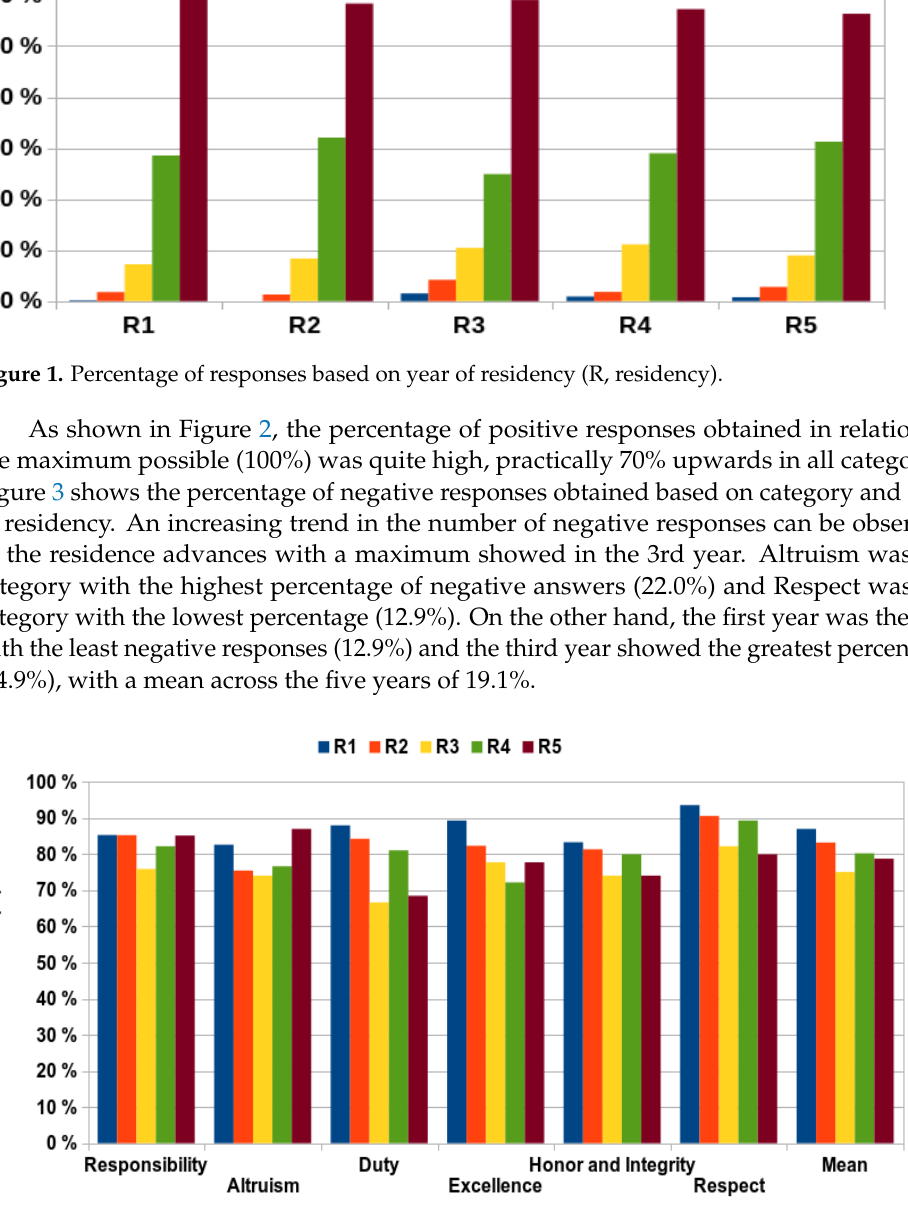
Figure 2. Mean percentage of professionalism categories in every year of residence.